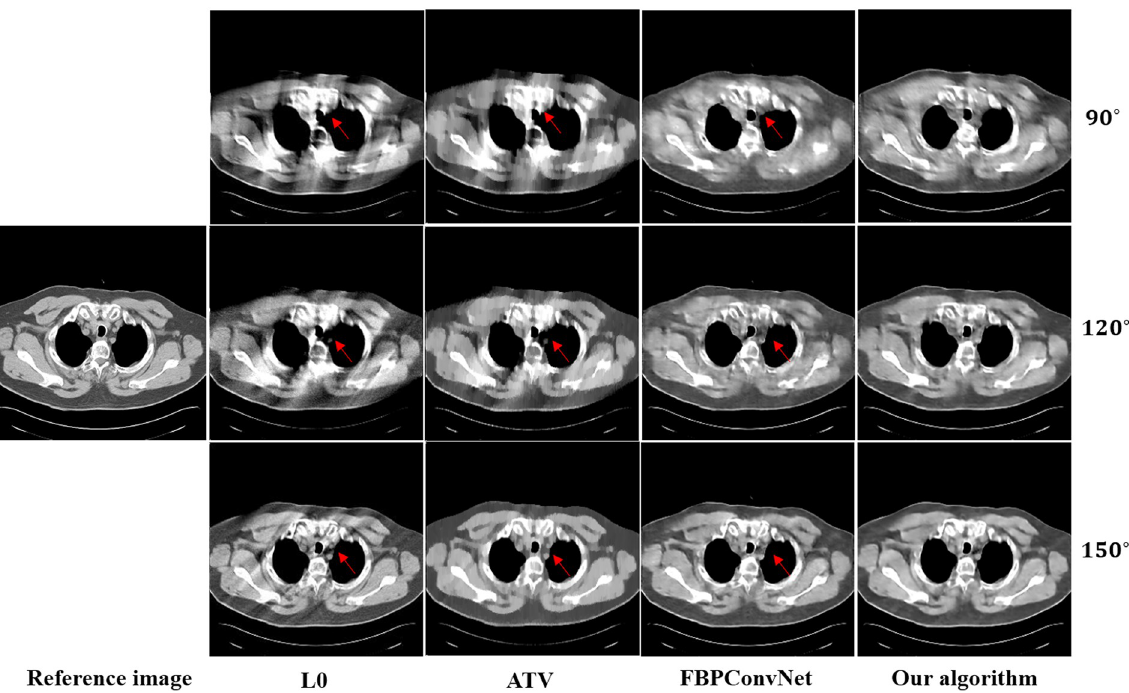
Fig 11. The reconstructed results of the chest image from the noise-add experiment. The image on the first column is the reference image. The subsequent columns are the results reconstructed using L0 method, ATV method, FBPConvNet method and our algorithm. The images from top to bottom in each row are the results reconstructed for the scan ranges [0˚, 90˚], [0˚, 120˚] and [0˚, 150˚], respectively. The location of red arrows present some obvious artifacts, and the display window is [800 1200] HU.